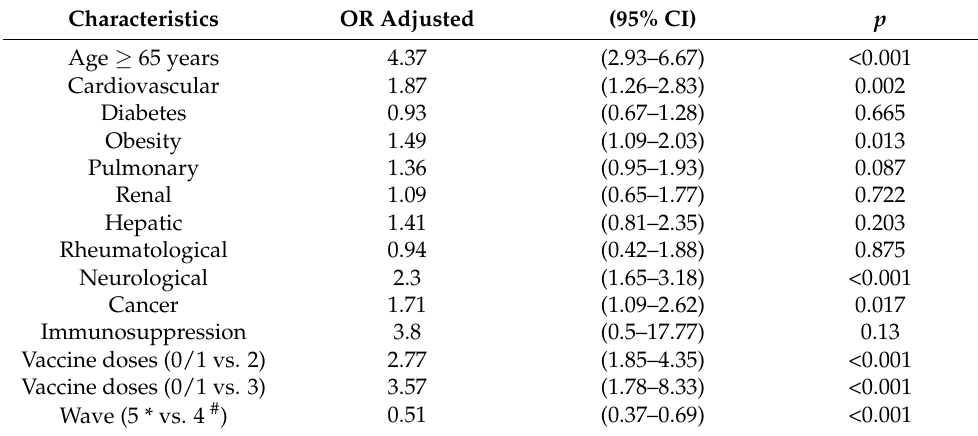
Table 5. Results of the multivariate logistic regression model predicting